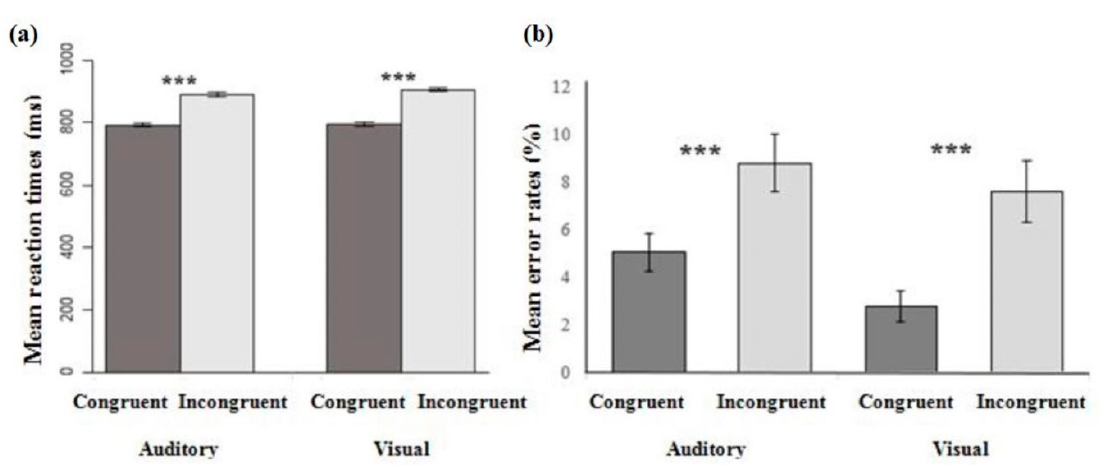
Figure 2. Mean reaction times (RTs) ( a ) and mean error rates ( b ) in response to the visual and auditory stimuli as a function of the congruency of the interaction. Error bars represent the standard error of the mean across participants and the asterisks indicate significant statistical differences ( p < 0.001).